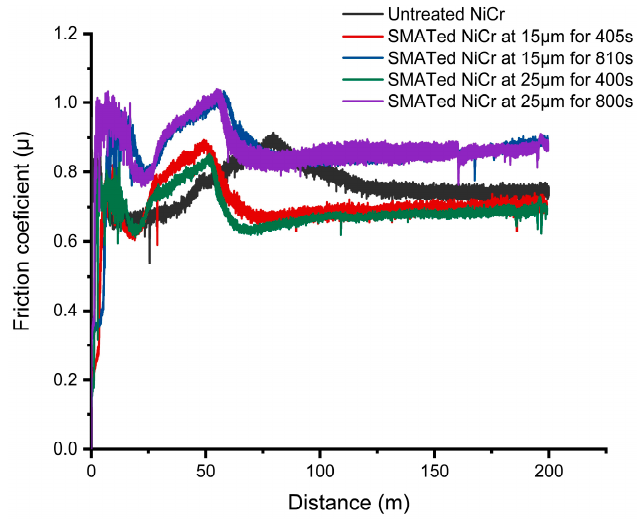
Figure 11. Friction coefficient of the coatings in different SMAT conditions.